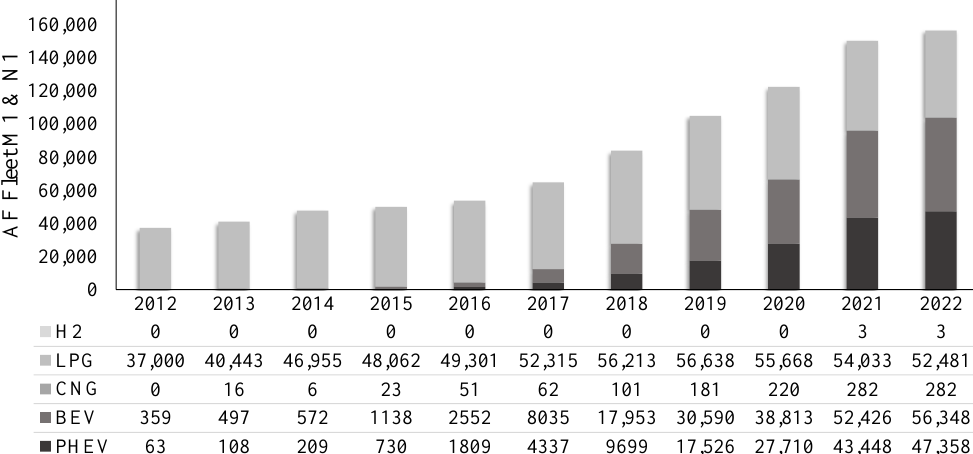
Figure 7. Alternative Fuels Fleet M1 & N1 in Portugal